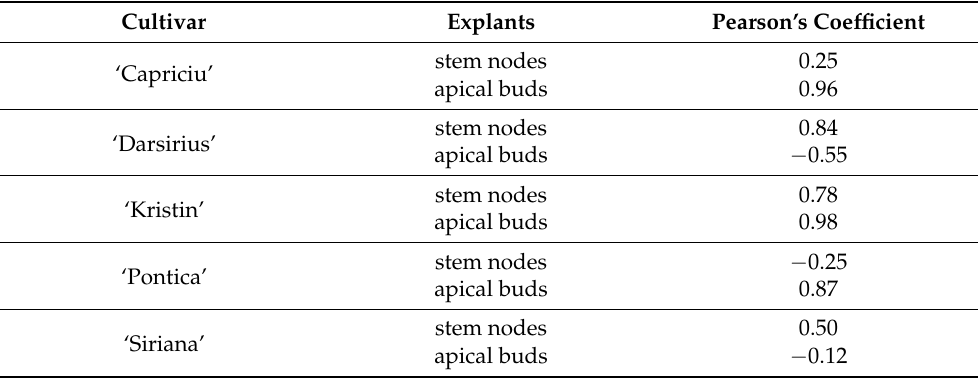
Figure 5. Shoot regeneration and rooting of stem nodes and apical buds on culture media with various cytokinins. ( a ) cv. ‘Pontica’ apex (V0); ( b ) cv. ‘Pontica’ nodes (V0); ( c ) cv. ‘Capriciu’ apex (V1); ( d ) cv. ‘Capriciu’ nodes (V1); ( e ) cv. ‘Siriana’ apex (V2); ( f ) cv. ‘Siriana’ nodes (V2); ( g ) cv. ‘Kristin’ apex (V3); ( h ) cv. ‘Kristin’ nodes (V3); ( i ) cv. ‘Darsirius’ apex (V4); ( j ) cv. ‘Darsirius’ nodes (V4). Arrows represent adventitious roots. Size bars = 1 cm. Table 5. Correlation coefficients on shoots height and roots length of analyzed tomato genotypes.